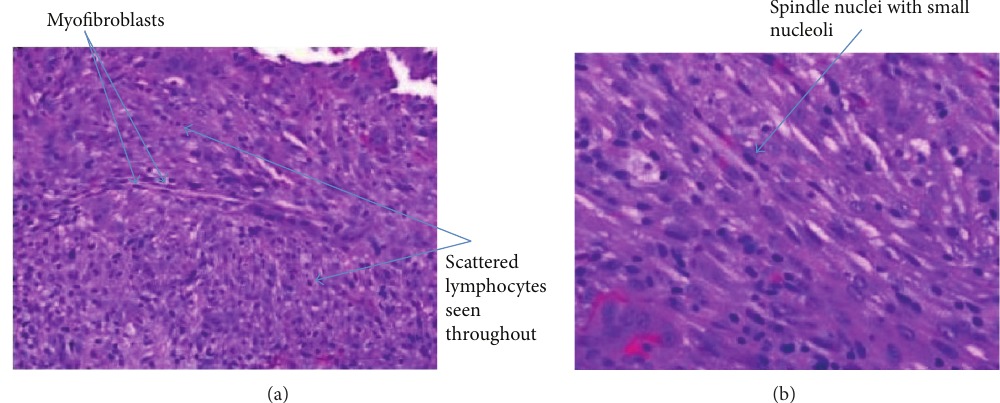
Figure 4: (a) Proliferation of plump spindle cells, with occasional giant cells and intermixed lymphocytes. Arrows illustrate lymphocytes and myofibroblasts. (b) Plump spindle cells with intermixed lymphocytes. Arrows demonstrating